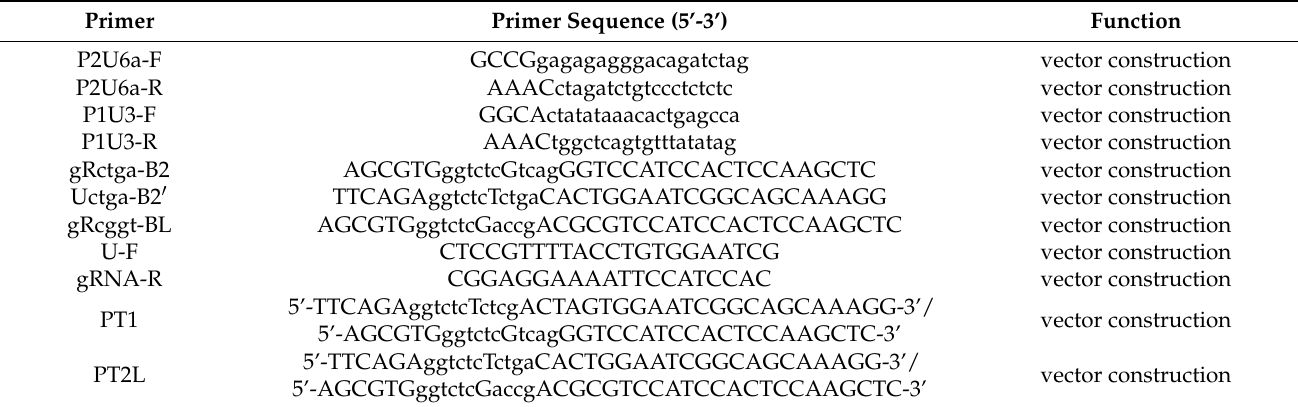
Table 1. List of the primers used for CRISPR-Cas9 expression vector construction.